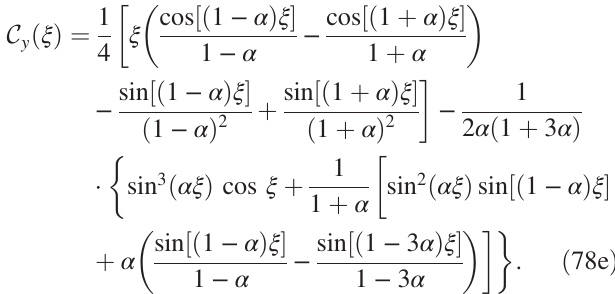
FIG. 12. Relativistic factor γ plotted vs time t for a sinusoidal- envelope circularly polarized laser pulse with angular frequency ω ¼ 2 × 10 15 s − 1 , maximum strength a width equal to 26.8 fs. The electron has an initial relativistic factor γ 0 ¼ 1000 .